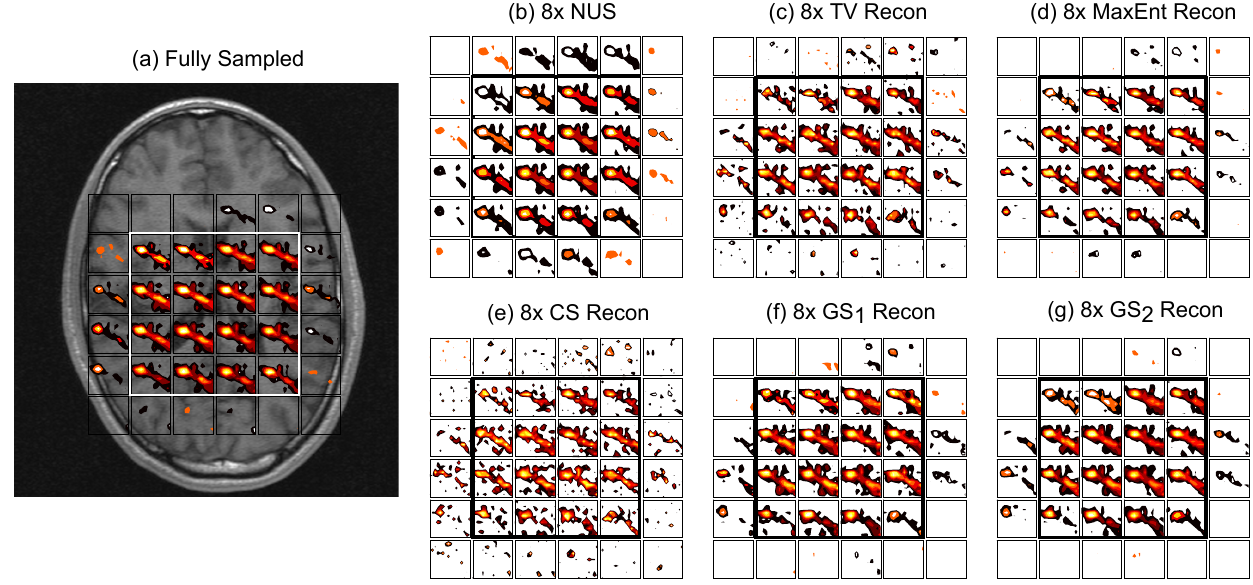
Figure 5. Spatial distribution of a 1.5 × 1.5 ppm spectral region centered at 2.5 ppm that contains the Glx and NAA/NAAG diagonal peaks from the ( a ) fully sampled in vivo 4D EP-COSI brain scan of a healthy 23 year old male ( b ) 8 × NUS and the ( c ) 8 × TV ( d ) 8